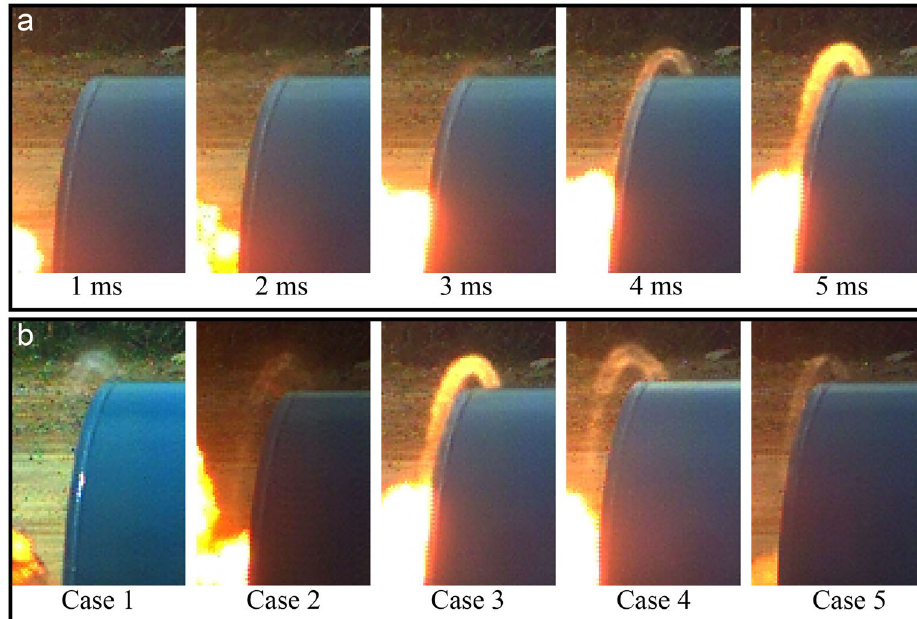
Figure 7. Vortex rings. ( a ) Vortex rings of Case 3. ( b ) Vortex rings at 5 ms.